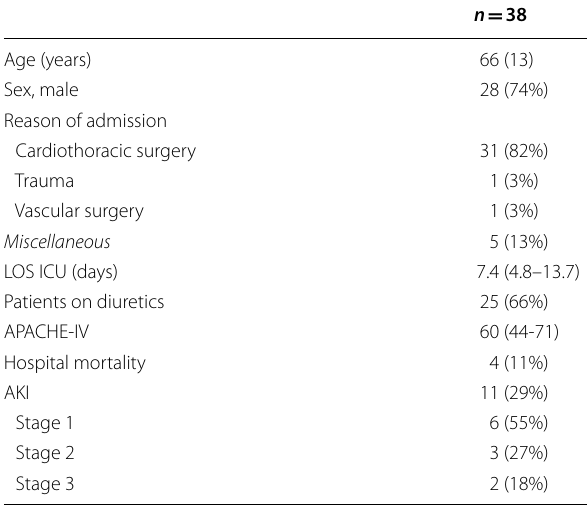
Table 1 Patients